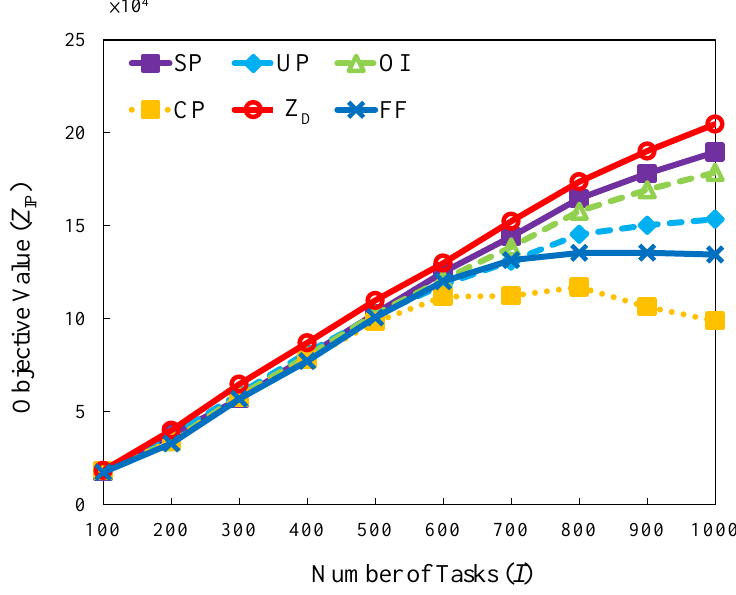
Figure 8. Objective value versus different number of tasks in uniform traffic